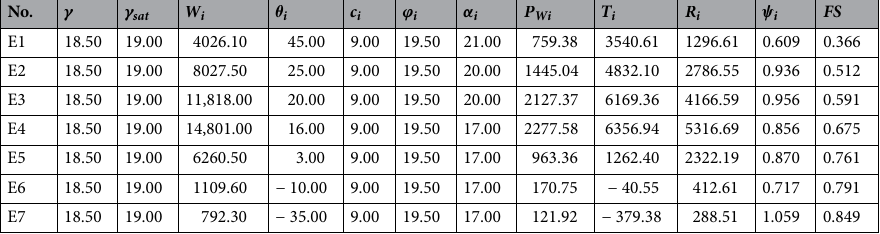
Table 6. Calculation results of slope stability in cross section 6-6 ′ (considering continuous